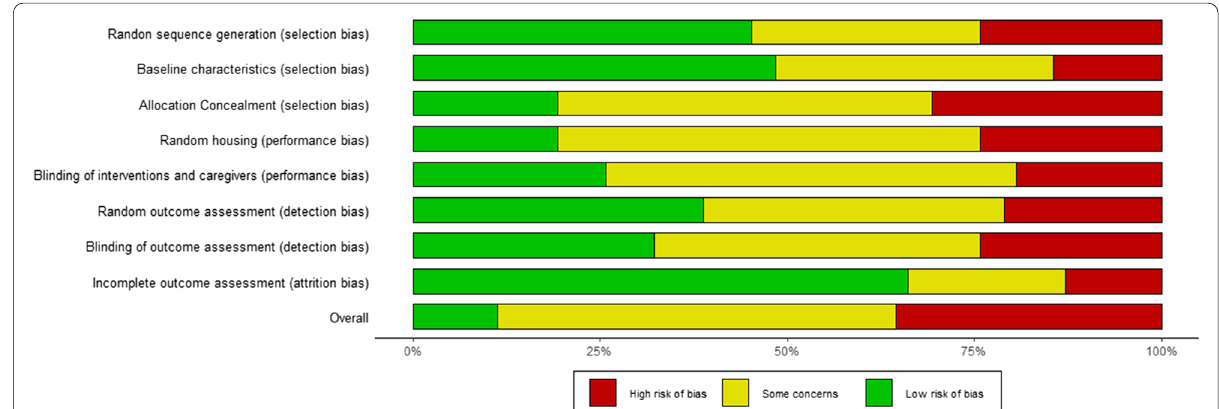
Fig. 2 SYRCLE’s risk of bias assessment for in vivo studies investigating the use of blood-derived products for the treatment of tendon pathologies